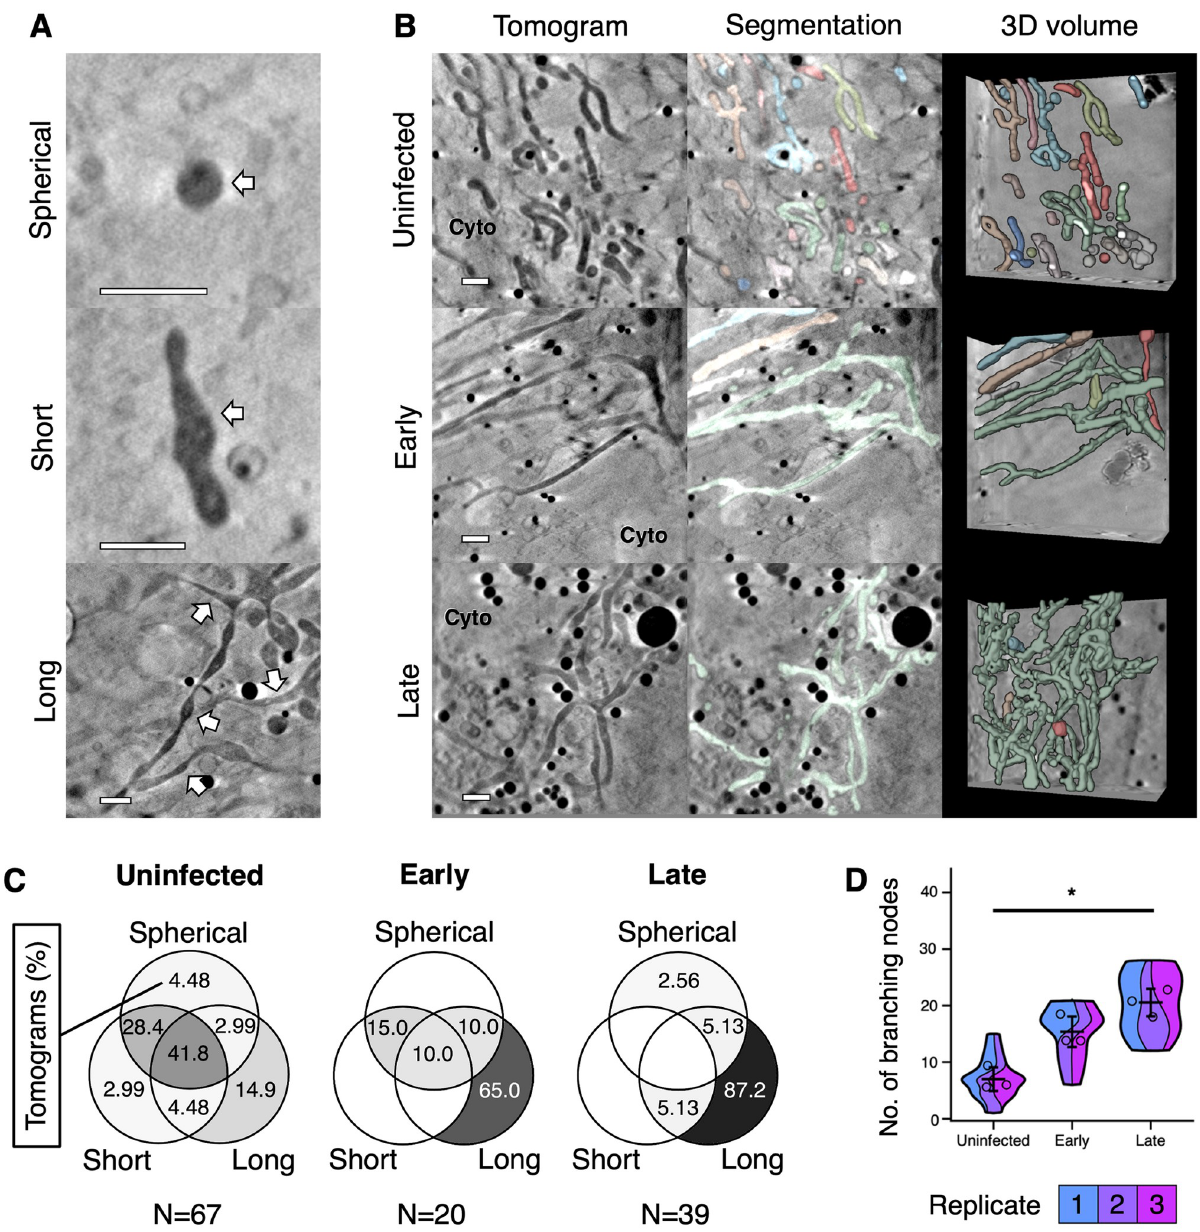
Fig 5. Remodelling of mitochondria during HSV-1 infection. Morphological changes to mitochondria were assessed from cryoSXT tomograms collected from uninfected cells and cells at early- or late-stages of infection with timestamp HSV-1. Data are representative of three independent experiments. Scale bars = 1 μ m. ( A ) Examples of spherical, short, and long mitochondria are indicated with white arrows. ( B ) A shift towards elongated and branched mitochondria was observed during infection. Mitochondria were segmented and differentiated using Contour [60] to highlight the abundance and 3D geometry of individual mitochondria. ( C ) Venn diagrams showing the percentage of tomograms at each stage of infection with Spherical, Short or Long mitochondria, or a combination of these phenotypes. The percentages of tomograms with long mitochondria were greater for cells at early- or late-stages of infection than for uninfected cells. Mitochondrial morphology was more heterogenous in uninfected cells. Combined percentages from all replicates are shown here and Venn diagrams for each replicate are shown in S2C Fig. ( D ) The numbers of branching nodes were calculated for 45 tomograms across all replicates and significant differences in the number of nodes between uninfected cells and those at late stages of infection were determined for each replicate using ANOVA and Tukey tests (p < 0.05). Error bars show mean ± SD.